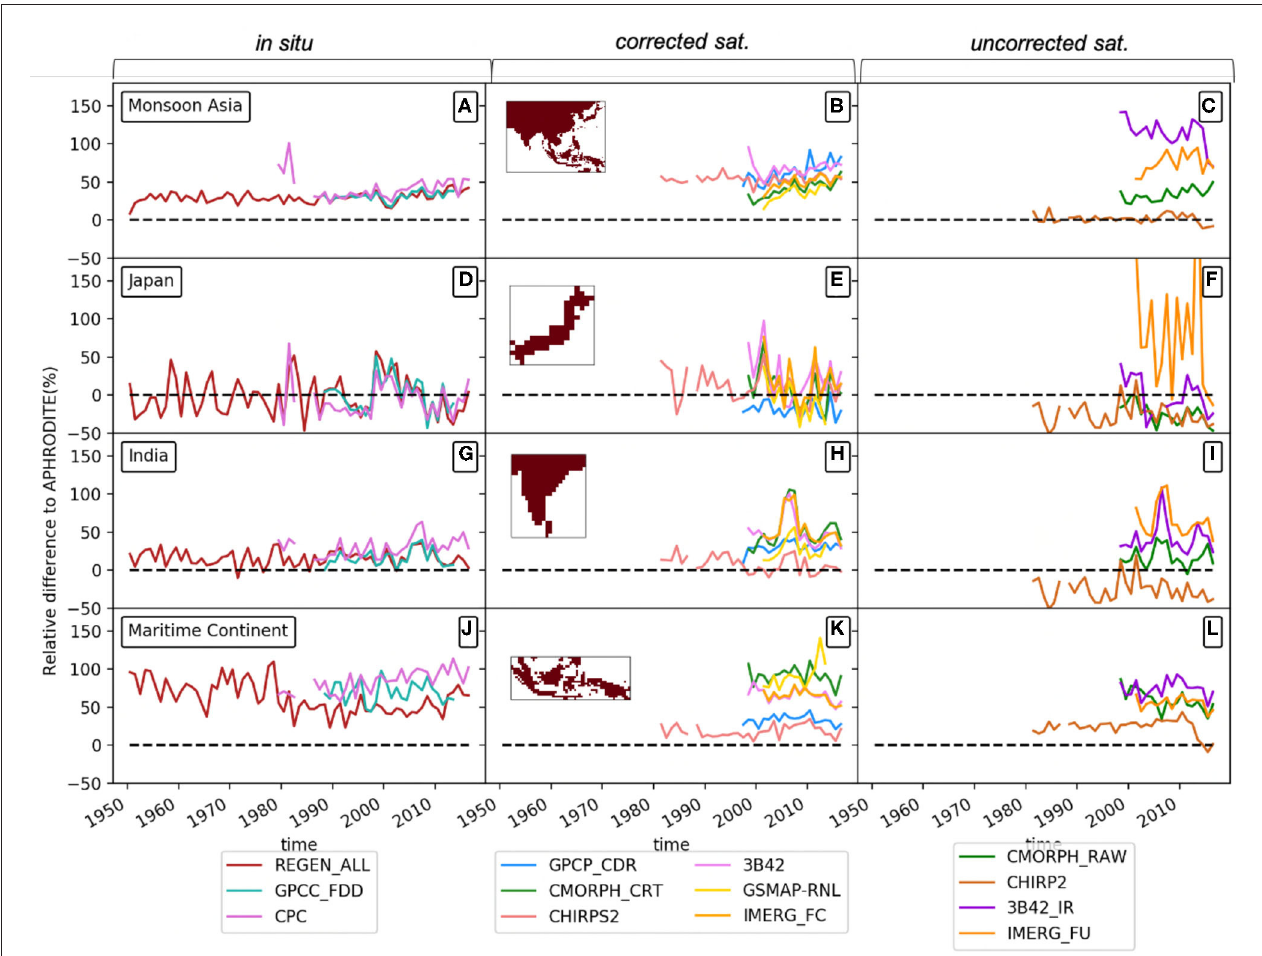
FIGURE 4 | Time series of regionally averaged relative differences (in %) for the annual wettest day (Rx1day) for each considered product compared to the baseline period (1961–1990) of APHRODITE. Products are clustered into three groups: in situ (the left column), corrected satellite (the middle column), and uncorrected satellite (the right column). Four regions are considered: (A–C) Monsoon Asia (60 ◦ E-150 ◦ E, 15 ◦ S-50 ◦ N), (D–F) Japan (129 ◦ E-146 ◦ E, 30 ◦ N-46 ◦ N), (G–I) India (70 ◦ E-92 ◦ E, 5 ◦ N-25 ◦ N), and (J–L) the Maritime Continent (95 ◦ E-150 ◦ E, 10 ◦ S-10 ◦ N). Regionally averaged Rx1day is calculated over the common area across all datasets (as shown by the inserted maps in the middle panel of each row).